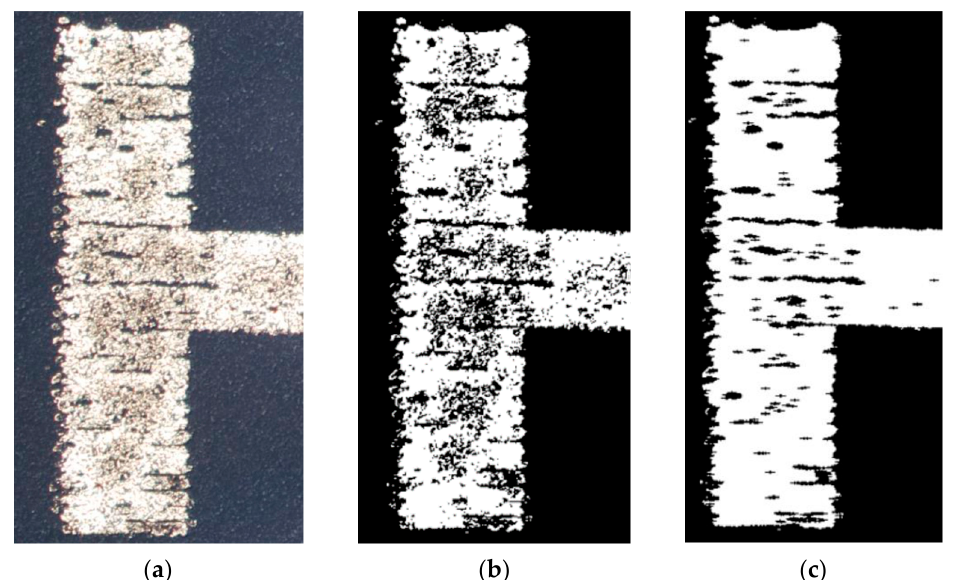
Figure 5. Example of closing specific gaps using “closing”: ( a ) A sample from the LCP substrate with poor print quality, ( b ) the basic mask using the thresholding method and ( c ) closing with an elliptical kernel (a = 11, b = 3).